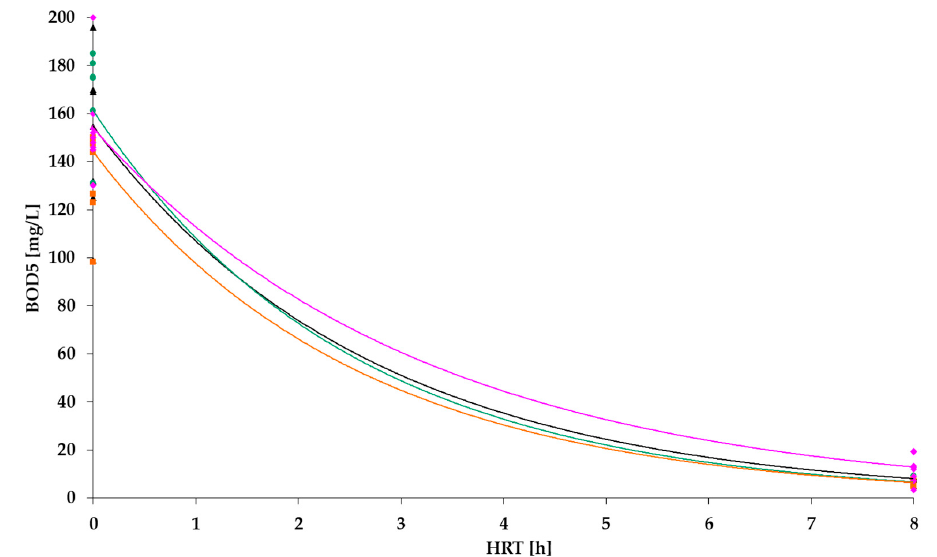
Figure 14. BOD removal dynamics if: floating carrier is PS (10% of reactor volume (black)); floating carrier is PV (20% of tank volume (green)); floating carrier is BB (20% of tank volume (orange)); no carrier in the reactor (magenta).